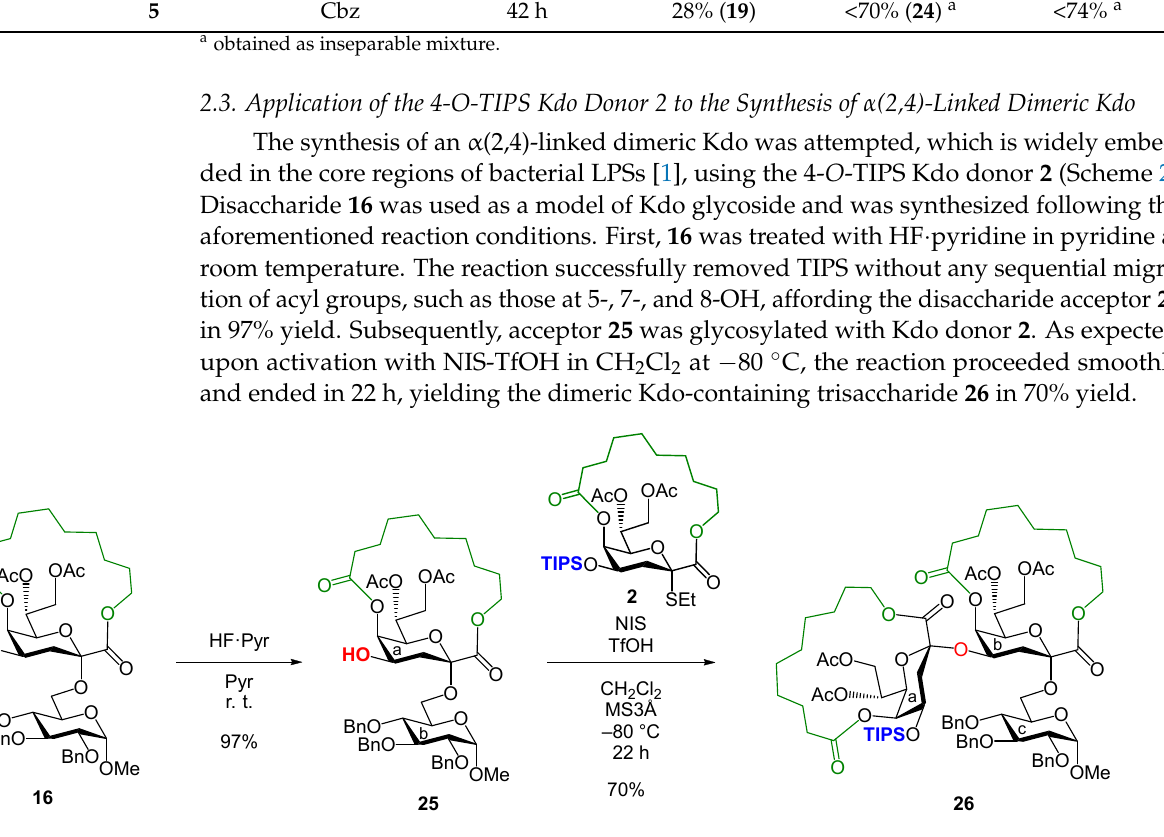
Scheme 2. Construction of the α (2,4) − linked dimeric Kdo sequence using the 4 − O − TIPS Kdo donor 2 .